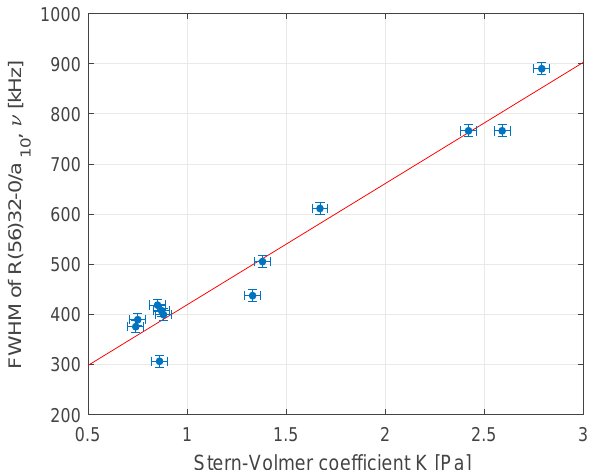
Figure 3. Relationship between laser-induced fluorescence (ISI LIF setup results) and hyperfine transition linewidth measurements (532 nm wavelength line R(56) 32-0, component a 10 ).